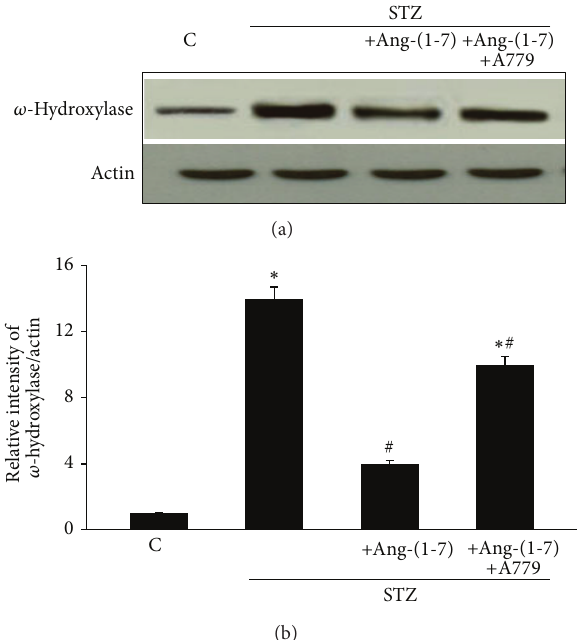
Figure 6: The level of omega-hydroxylase protein expression in the corpus cavernosum of nondiabetic (C), diabetic (STZ), and STZ-rats chronically treated either with Ang-(1-7) alone (STZ + Ang-(1-7)) or in combination with A779 (STZ + Ang-(1-7) + A779). Panel (a) is a representative western blot showing the level of omega( 𝜔 )-hydroxylase protein and 𝛽 -actin as a loading control. Panels (b) and (C) are densitometry histograms showing levels of omega( 𝜔 )-hydroxylase protein normalized to actin. 𝑁 = 4 ; Mean ± SD. Asterisk ( ∗ ) indicates significantly different ( 𝑃 < 0.05 ) mean values from normal nondiabetic rats (C), whereas hash (#) indicates significantly different mean values ( 𝑃 < 0.05 ) from diabetic rats